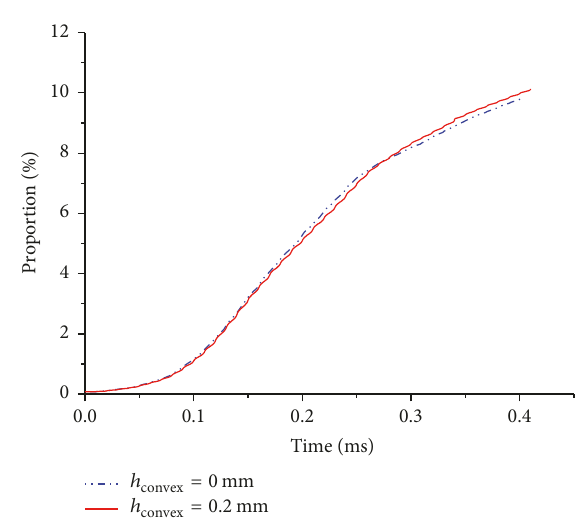
Figure10:Theeffectoftheconvexsurfaceonthetotalkineticenergy